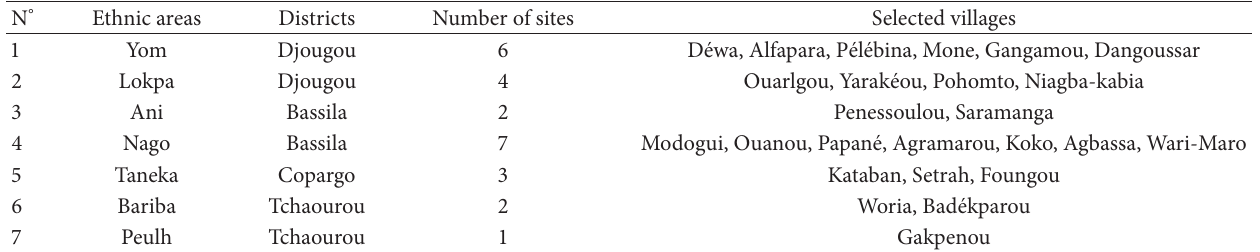
Table 1: Administrative localisation of the ethnic areas and sites